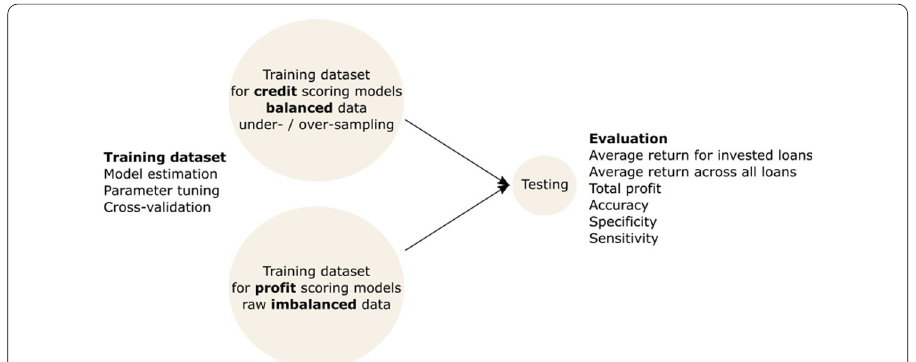
Fig. 1 Higher-level overview of the methodological